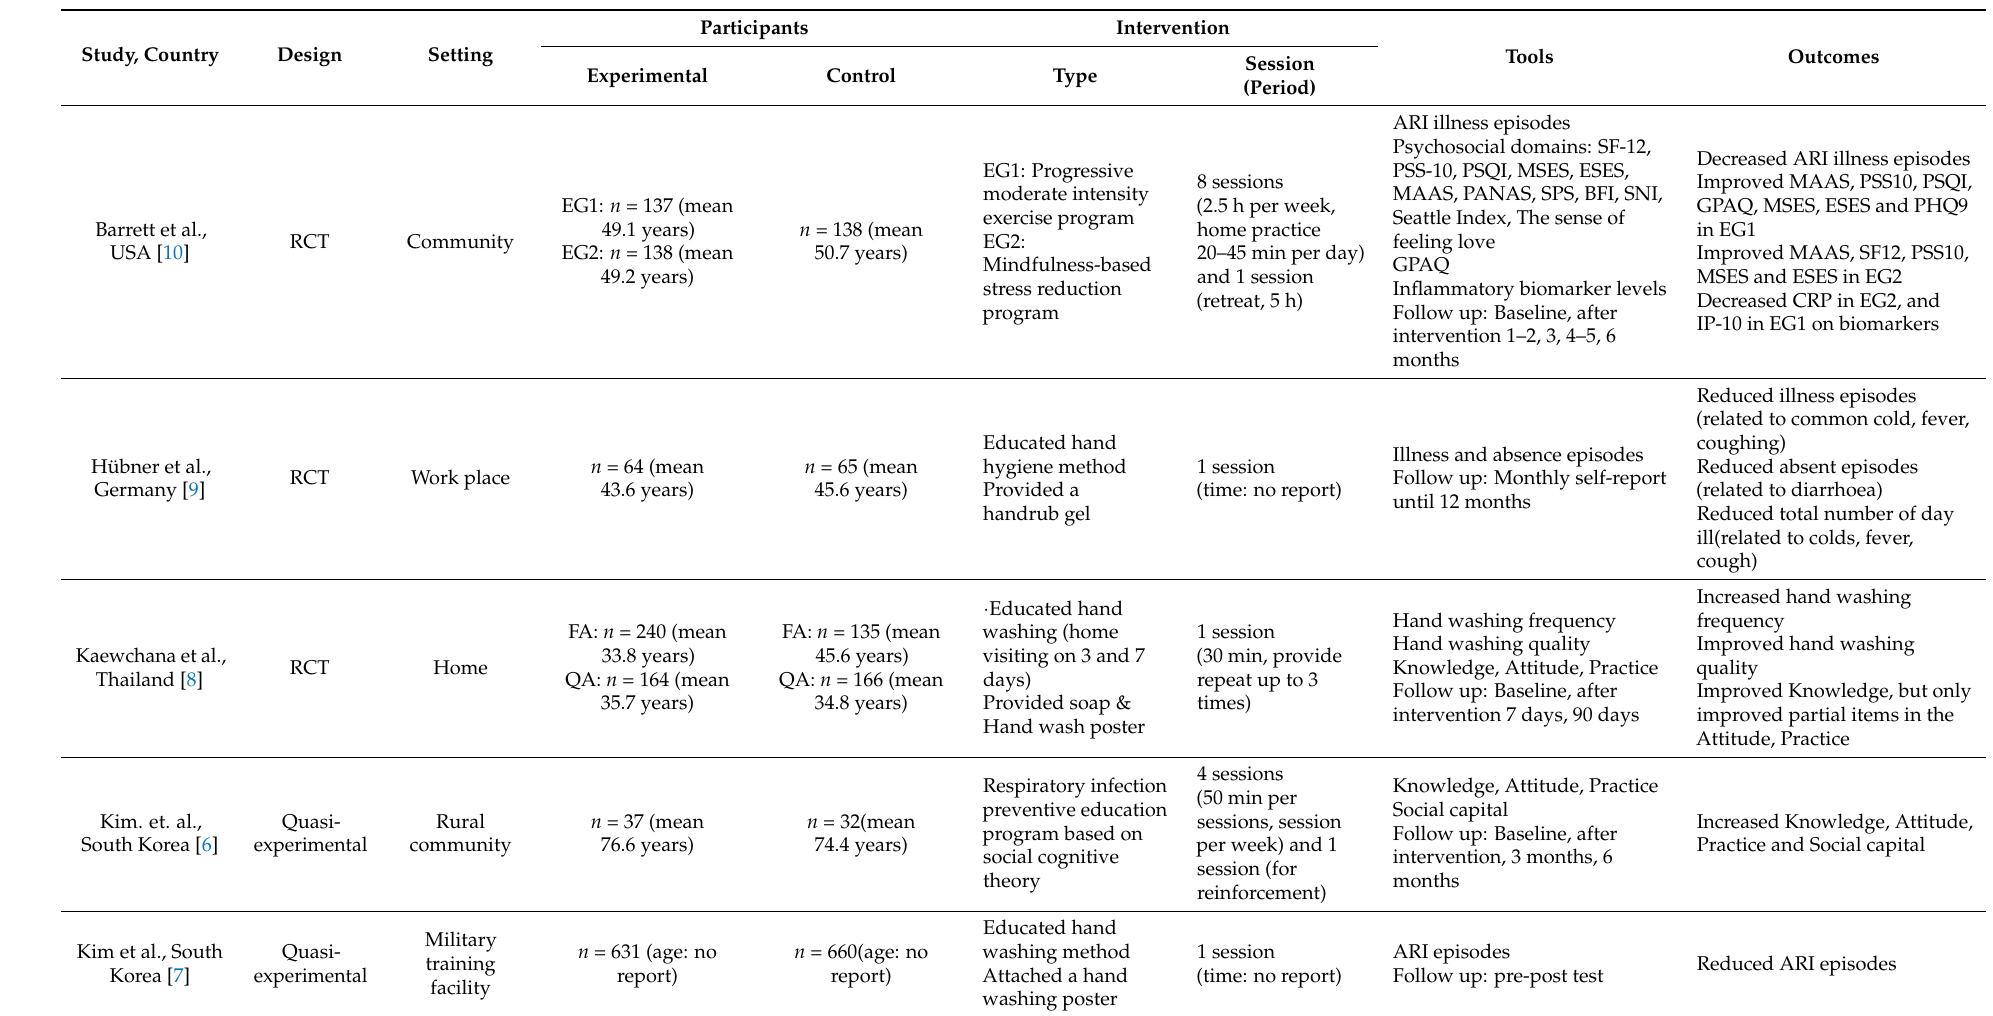
Table 3. Characteristics and training outcomes for all enrolled 9 studies based on PICOS